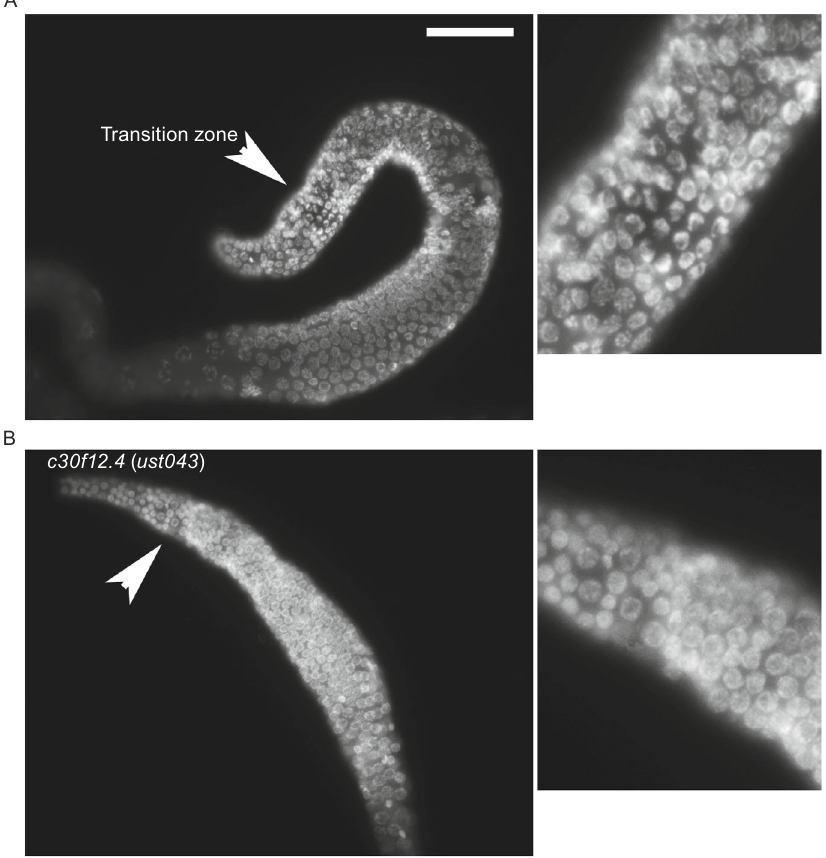
Figure 3. Absence of transition zone in c30f12 .4 mutant worms. Each panel shows Hoechst-stained nuclei in an isolated gonad. (A) Wild-type gonad, arrowhead: transition zone. (B) C30f12.4 mutant gonad. Scale bar = 50